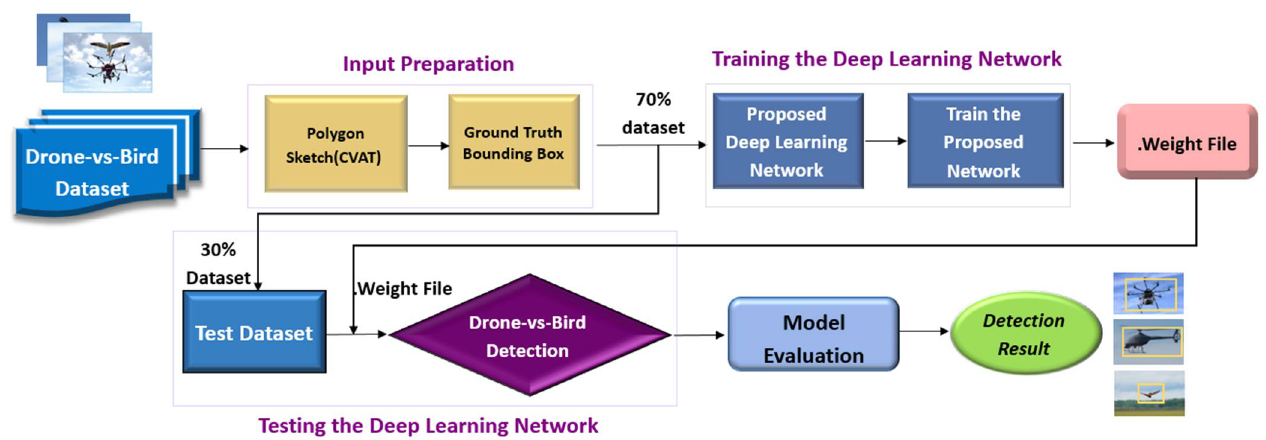
Figure 5. Proposed detection and recognition diagram using convolutional neural network.